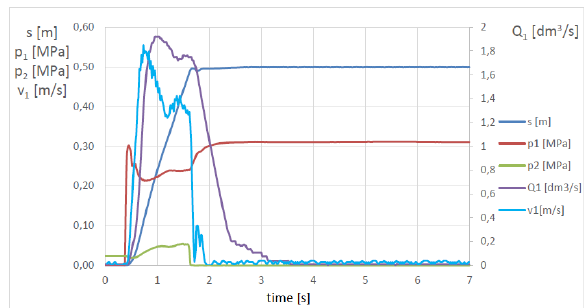
Fig.13. Graph of measured data for extension of piston rod, task with reservoir, for working pressure 0.3 𝑀𝑃𝑎